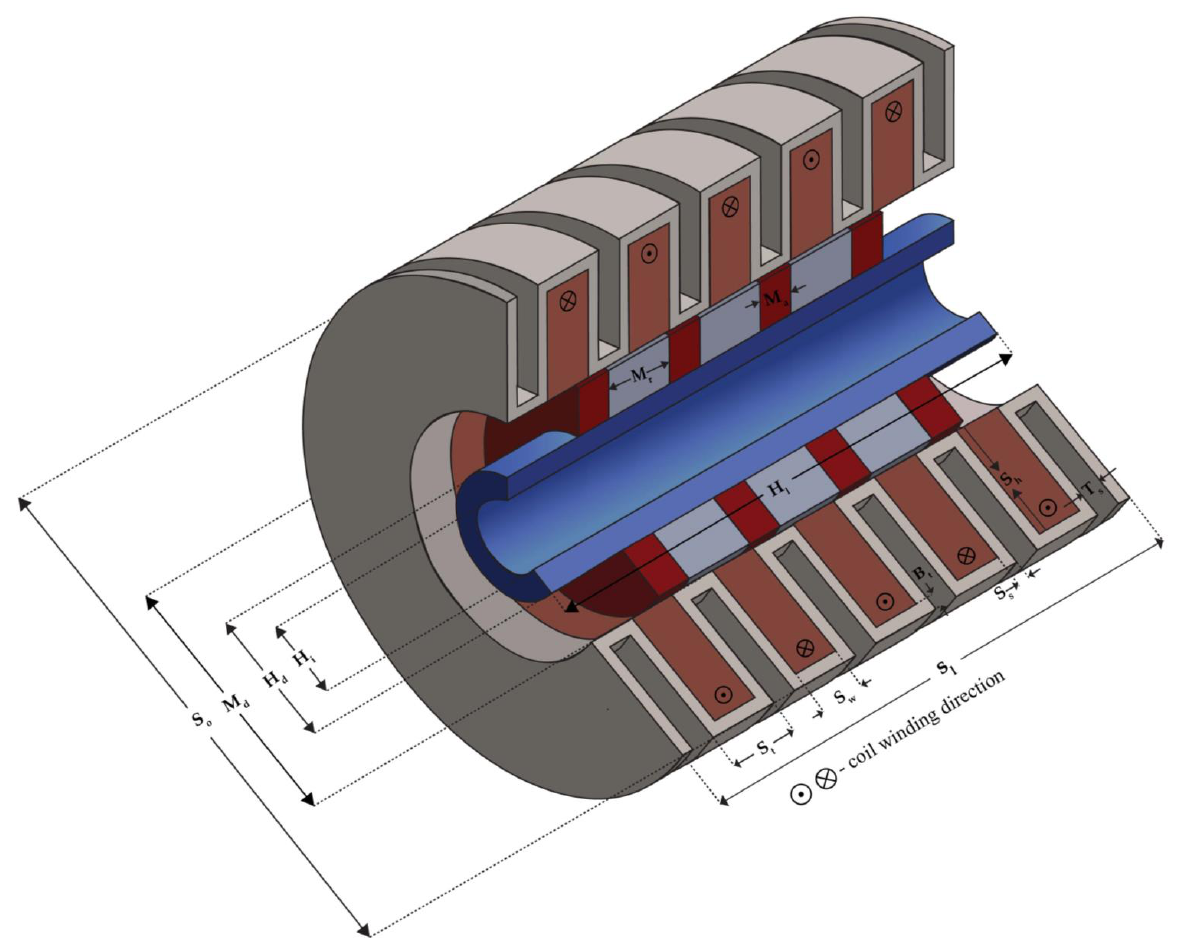
Figure 1. Cut-section schematic of the linear